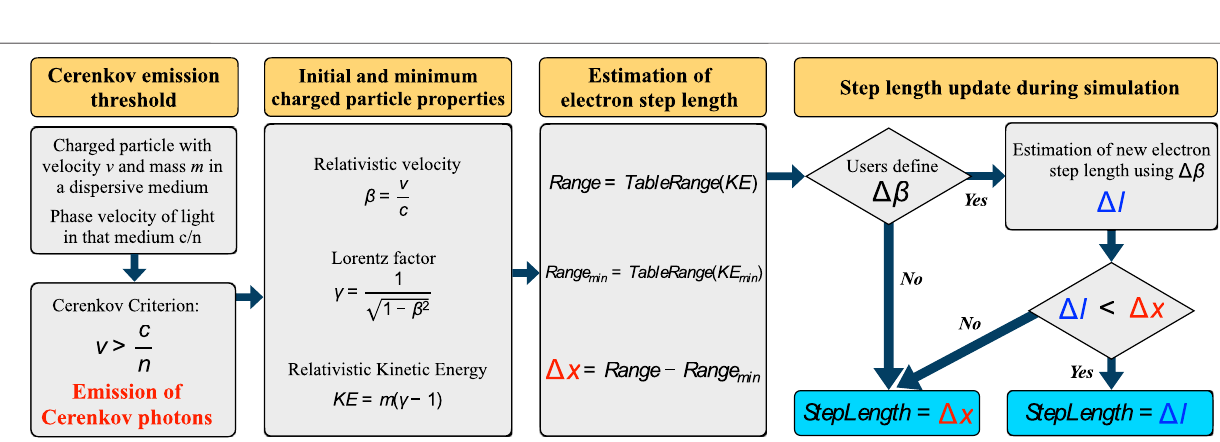
FIGURE 1 | Examples of an electron track (green) within a BGO crystal generated by a 511 keV gamma (red) simulated in GATE/Geant4. Cerenkov photons (blue arrows)areproducedalongtheelectrontrack. (A) UsingGeant4defaultsetting,theelectronmeansteplengthwasof183 μ m,andtheyperformedinaverage2stepsper track. Most of the Cerenkov photons were emitted in the forward direction. (B) When imposing a 10% limitation on the electron velocity change per step, the electrons scattered 4 times in average and their mean step length was reduced to 52 μ m. (C) By strongly limiting the electron velocity change per step to 0.04%, the mean steplengthwasreducedto0.205 μ mandboththeelectronsandtheCerenkovphotonslosetheirdirectionality.This fi gureshowsthenumberofe − stepspertrackofthe speci fi c tracks depicted.